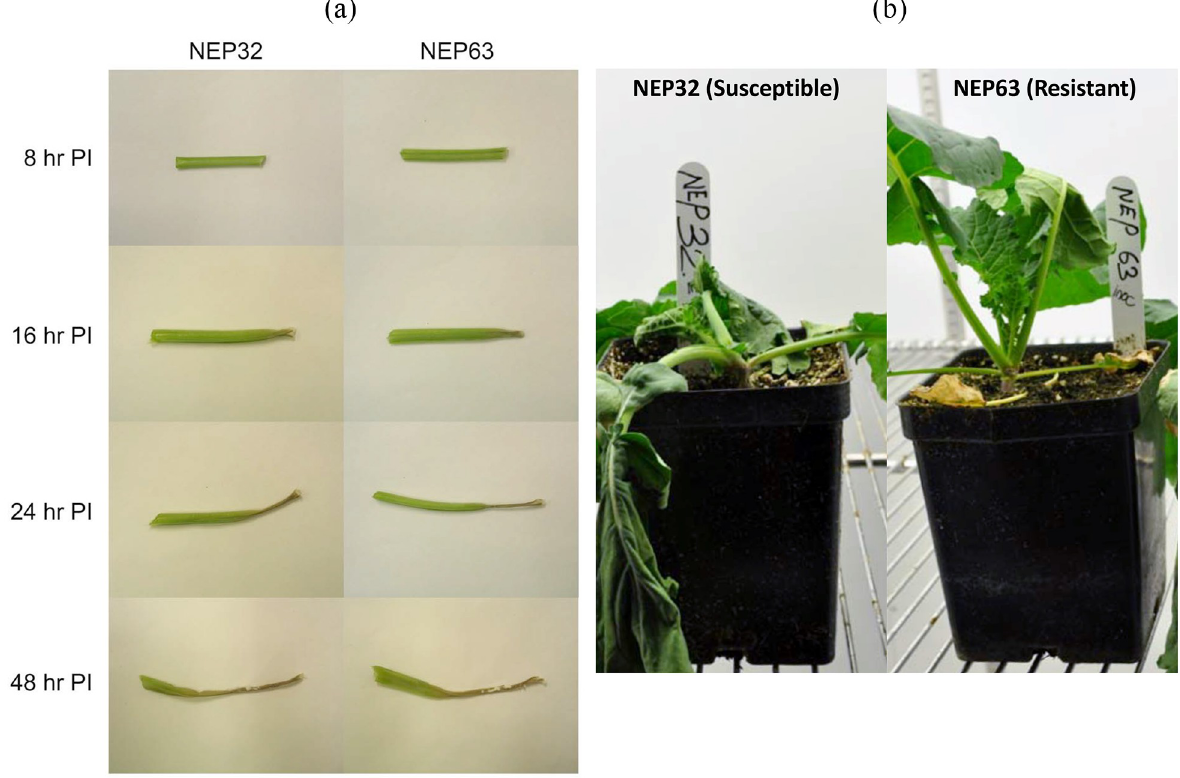
Fig 1. Disease development on resistant and susceptible canola lines. (a). Comparison of the appearance of representative inoculated petioles from both canola lines. The necrotic lesion spreads from the point of inoculation (i.e., petiole tip) along the length of the petiole. There are no apparent differences between NEP32 and NEP63 canola petioles. (b). Appearance of resistant (NEP 63) and susceptible (NEP32) canola four days post inoculation with S . sclerotiorum . Disease symptoms are more apparent in the susceptible line.